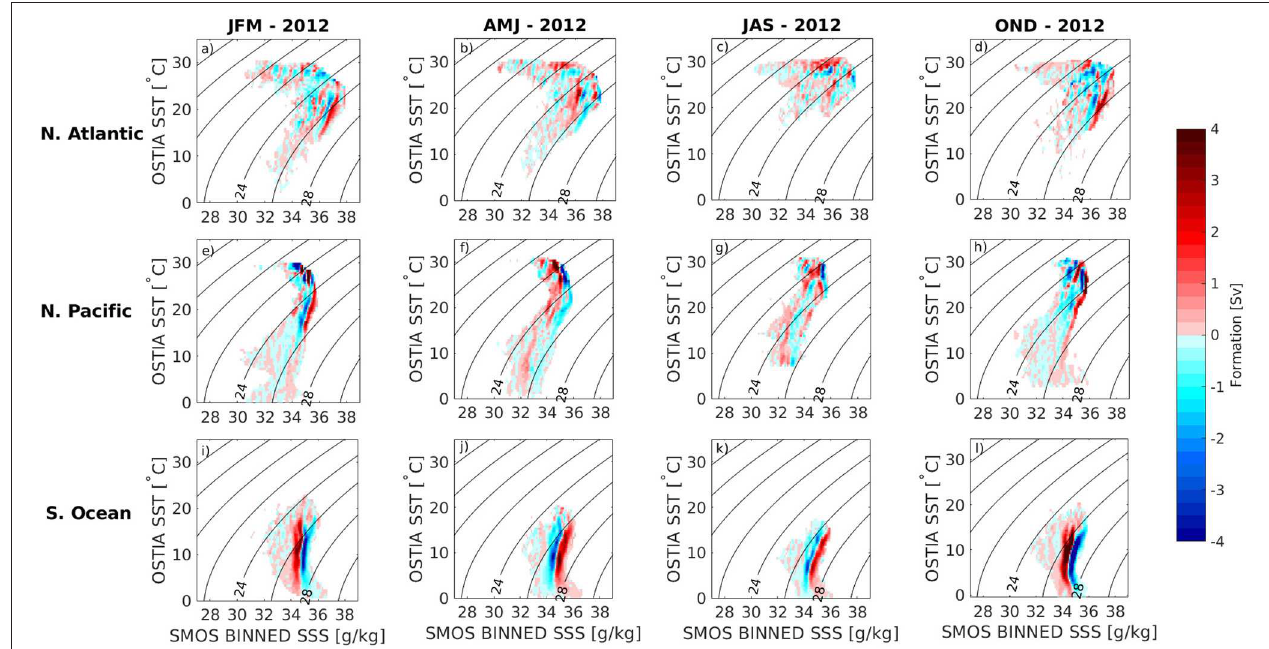
FIGURE 4 | Seasonal evolution of formation for the North Atlantic (a–d) , North Pacific (e–h) , and Southern Ocean (i–l) , averaged over winter (JFM), spring (AMJ), summer (JAS), and autumn (OND) of the year 2012.